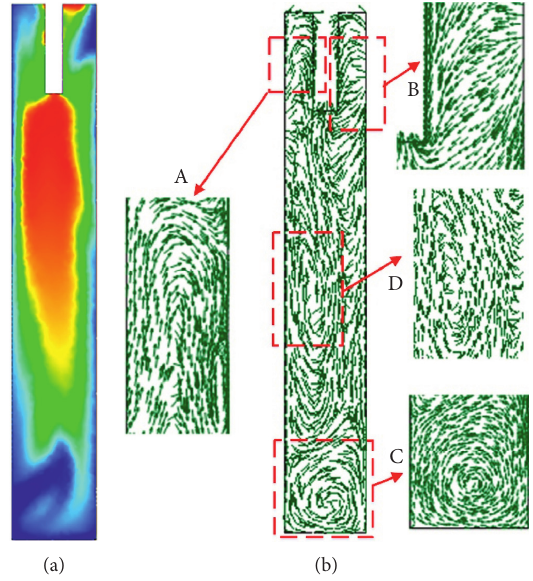
Figure 8: Flow field analysis. (a) Gas volume distribution. (b) Velocity vector.